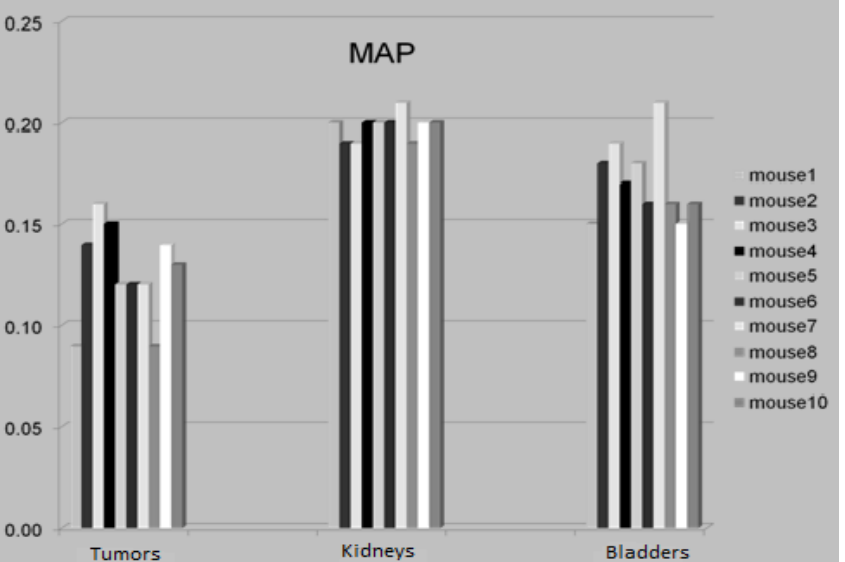
Figure 5. The attenuation amplitude of the tumors, kidneys and bladders